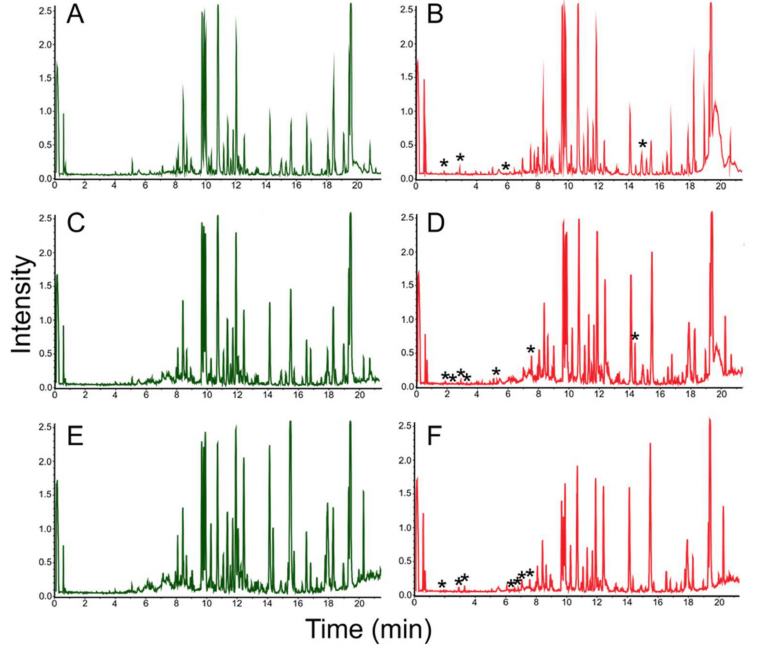
Figure 5. Chromatograms of natural products extracted from MM with pine sawdust added (left column, control parameters) and MM (left column, experimental parameters) where Streptomyces sp. LPB2019K190-4 was cultivated: ( A ) MM media without sawdust (control); ( B ) Streptomyces sp. LPB2019K190-4 cultivated on MM media without sawdust (control); ( C ) MM media with a relatively low content of pine sawdust (control); ( D ) Streptomyces sp. LPB2019K190-4 cultivated on MM media with a relatively low content of pine sawdust; ( E ) MM media with a relatively high content of pine sawdust (control); ( F ) Streptomyces sp. LPB2019K190-4 cultivated on MM media with a relatively high content of pine sawdust. *-asterisks indicate the differences (new peaks) between MS-spectrums of control and experimental